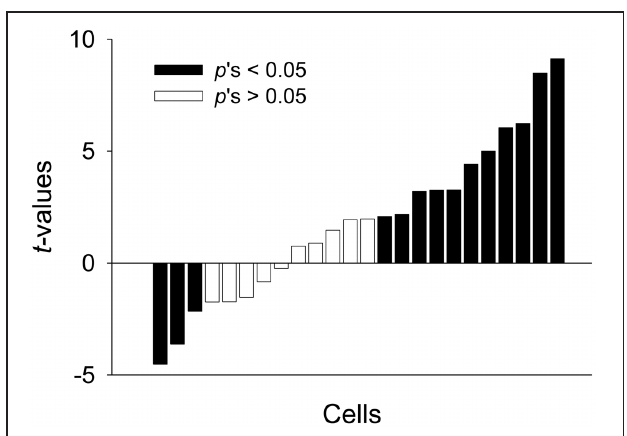
FIGURE 7 | Modulation of activity in PFUs. The direction and amplitude of the modulation are expressed as paired t- values for each unit, which were computed from Z- score differences between Context A and B. The t- values were arranged in the order from the most negative to most positive values. A positive value indicates more activity in Context A. The dark bars represent statistically significant differences in firing rate between the two contexts and white bars represent non-significant